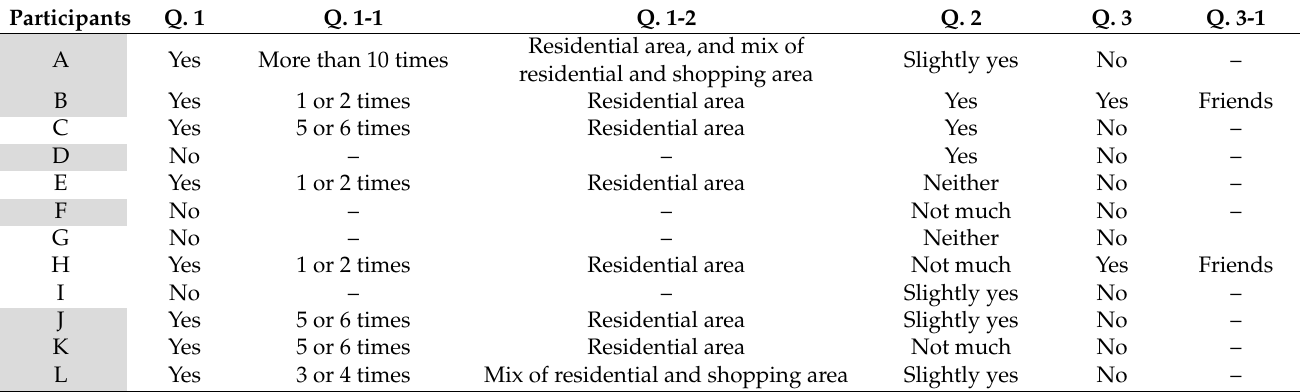
Table 6. Results of the follow-up survey conducted 3 months after the